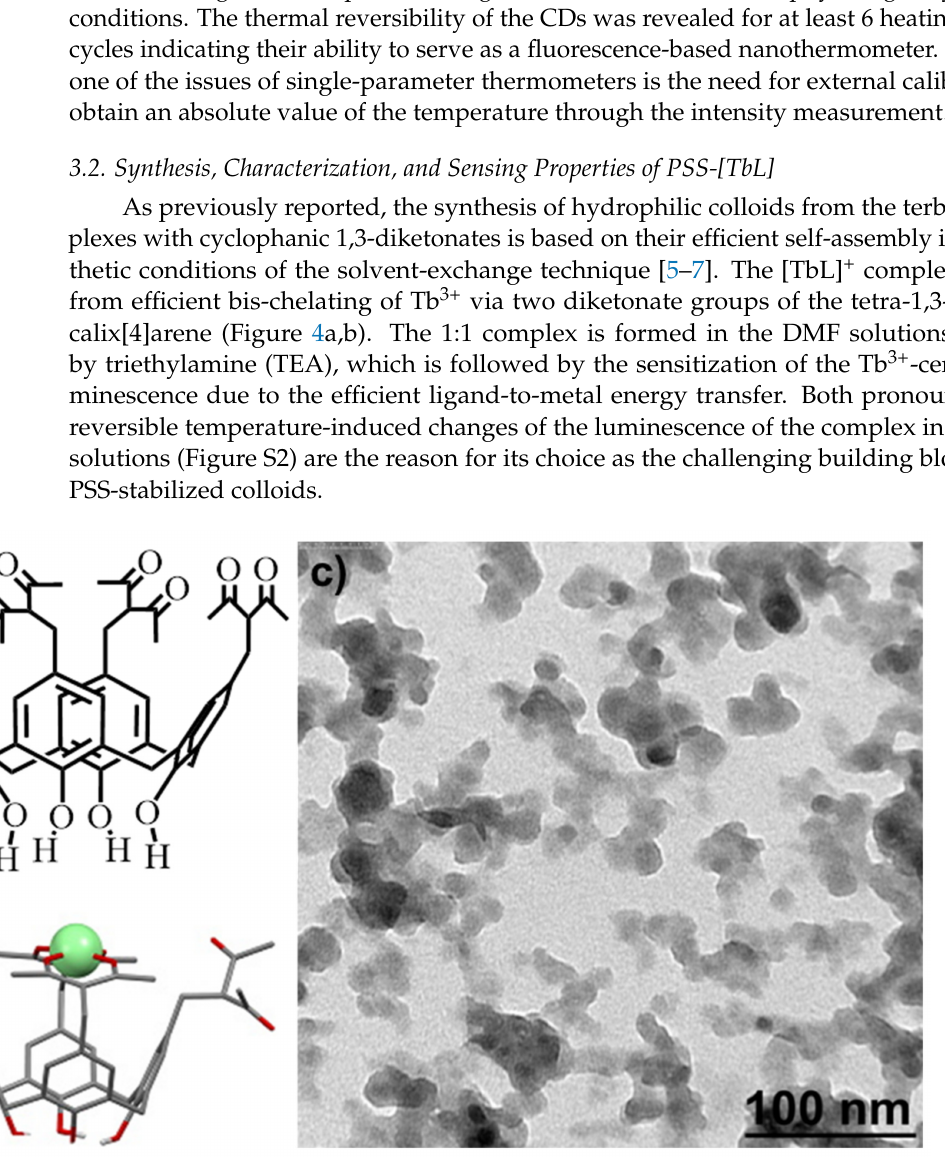
Figure 4. Structure of ( a ) L and ( b ) [TbL] + . Reprinted with permission from Ref. [33]. Copyright 2016 Elsevier. ( c ) TEM image of dried PSS-[TbL]